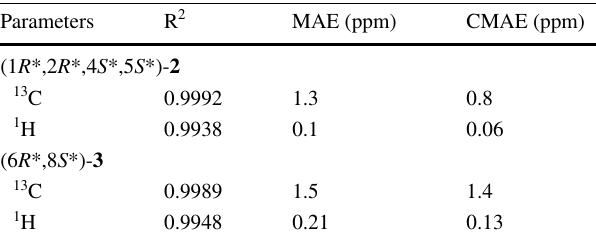
Fig. 3 X-ray crystallographic structure of